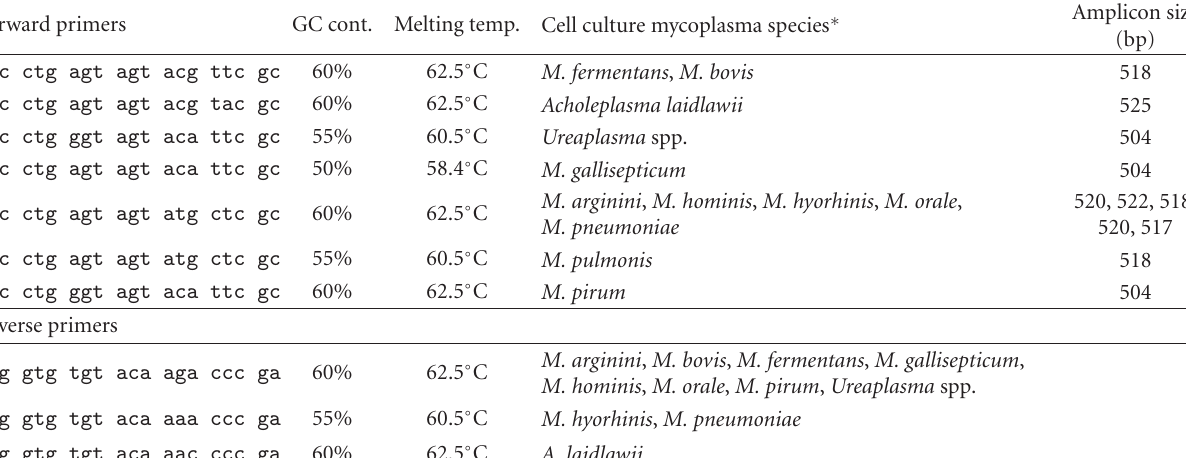
Table 1: Oligonucleotide primers used for the PCR detection of mycoplasma contamination. Forward